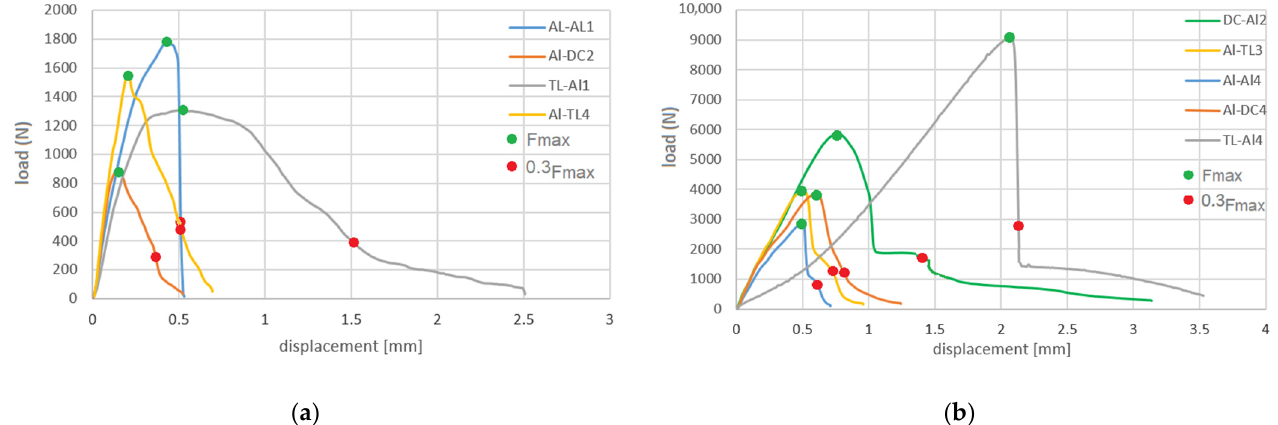
Figure 16. Load–displacement curves successfully made by ( a ) FD and ( b ) FD + AB technology